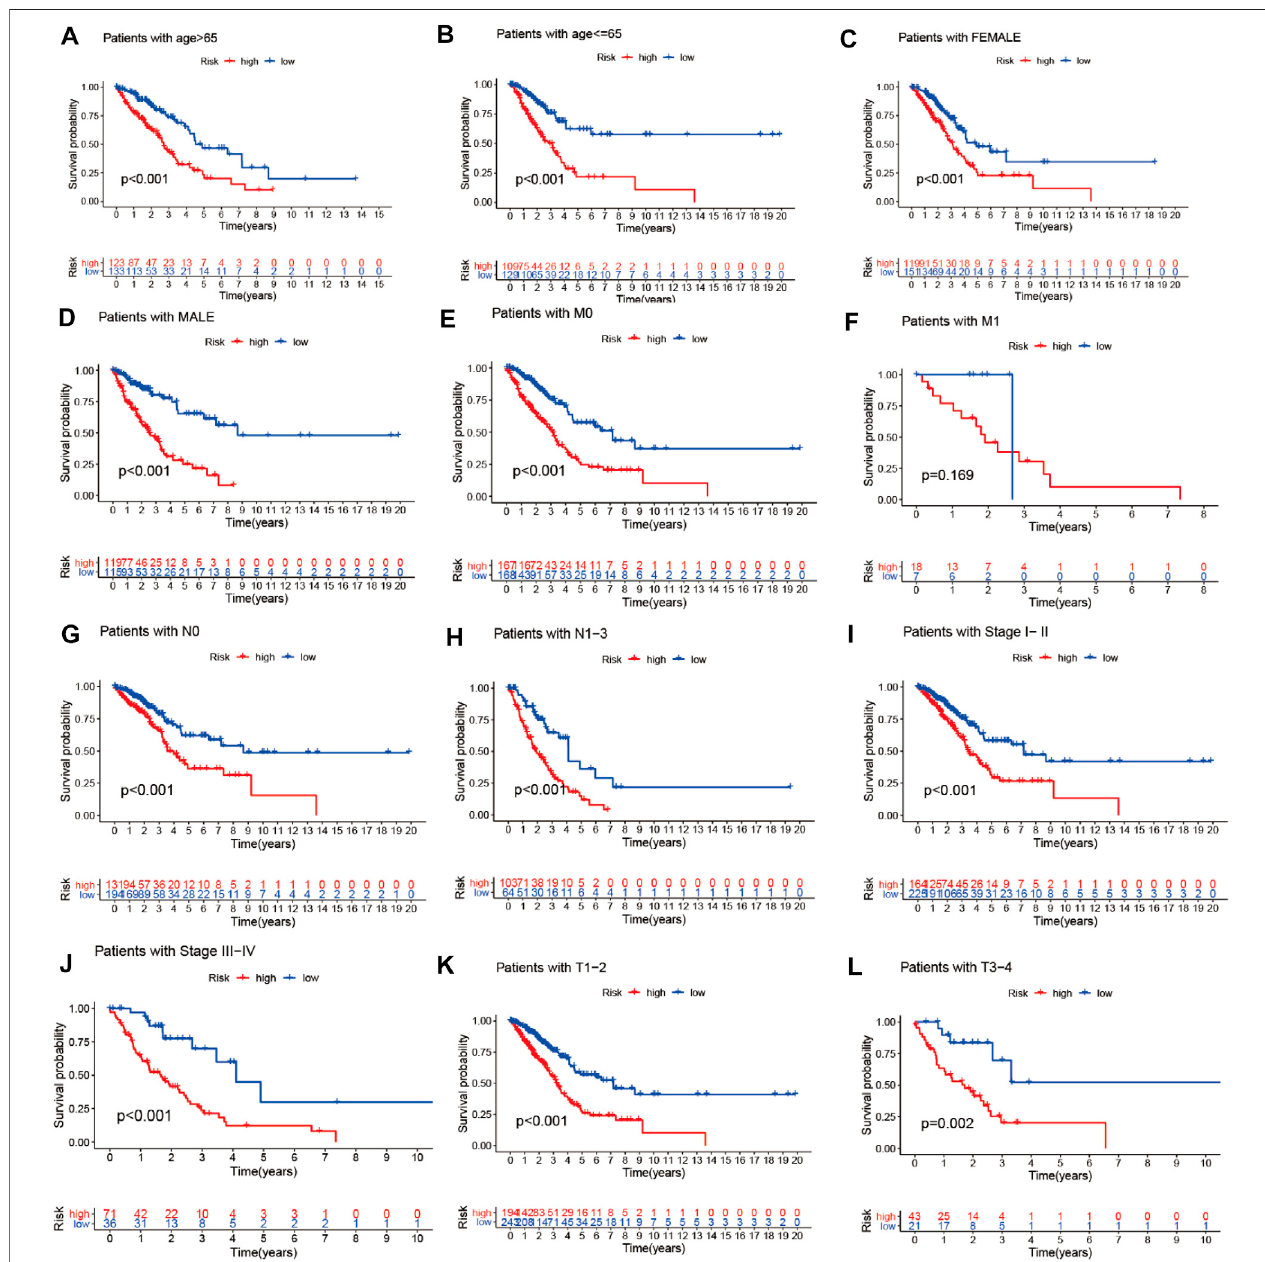
FIGURE 12 | Prognostic model validation of clinical grouping. (A – L) Survival analysis of LUAD patients by age, gender, pathological M0/M1 stage, pathological T1 – 2/3 – 4 stage, pathological N0/N1 – 3 stage, and pathological stage I – II/III – IV in the high- and low-risk cohorts.